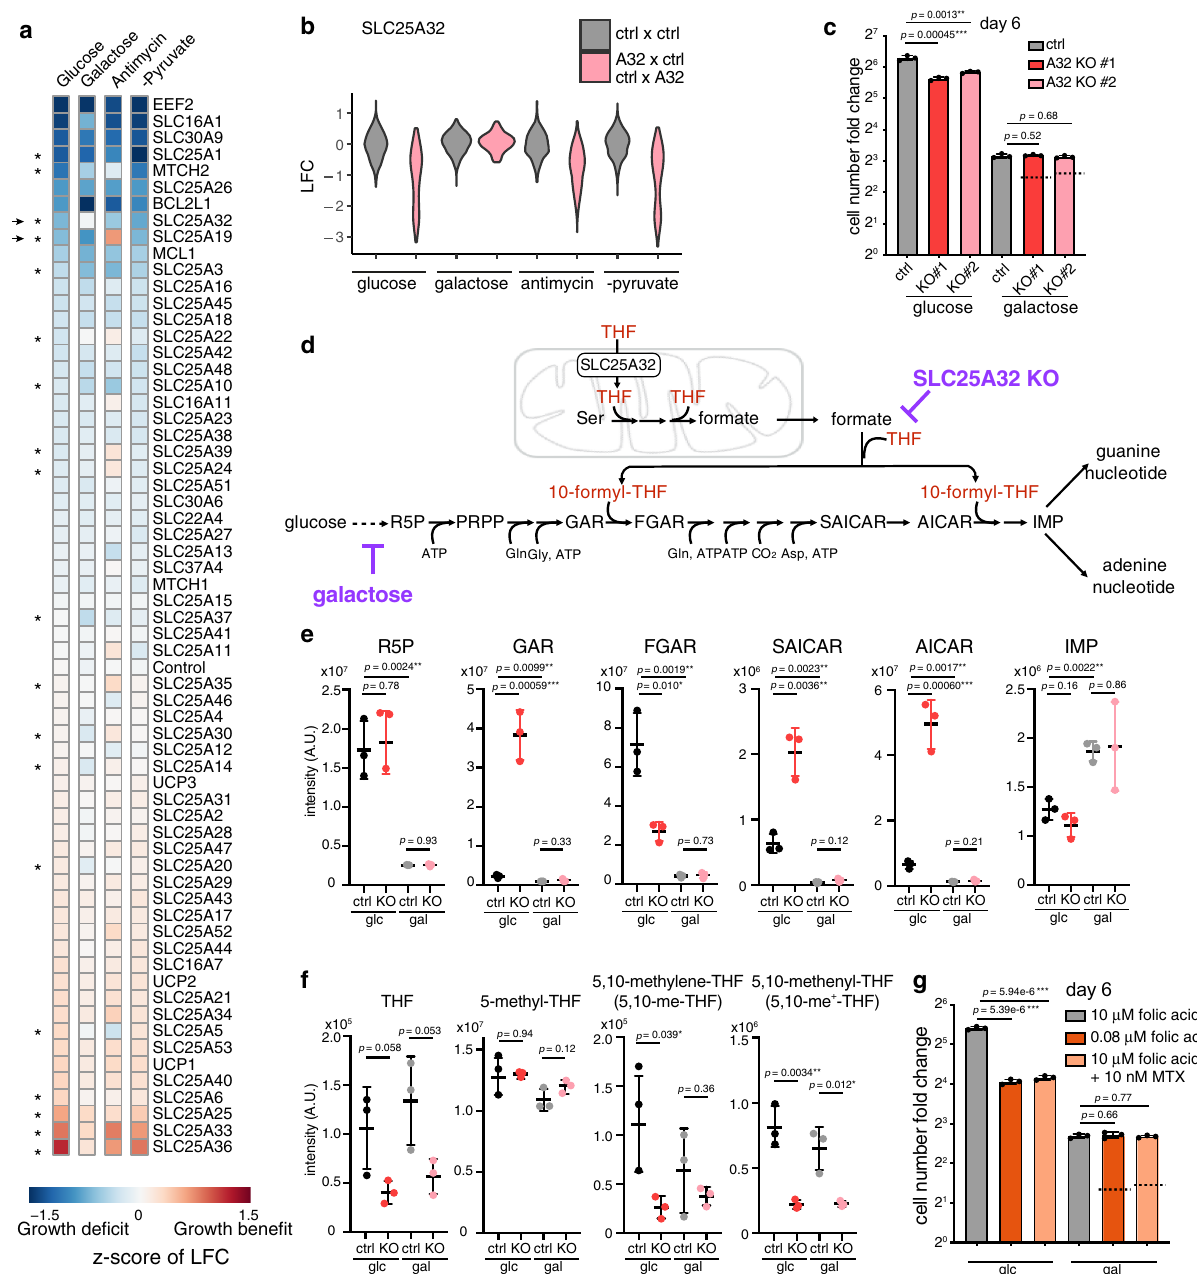
Fig. 2 Gene x Environment (GxE) mapping indicates that loss of mitochondrial folate metabolism can be buffered in galactose condition. a A heatmap depicts the fi tness of single gene KOs across all four media conditions. Values are Z -scores of log fold change (LFC) value of the targeting guide abundance. Asterisks highlight the 19 signi fi cant “ GxE ” interactions, i.e., those knockouts that cause fi tness phenotypes differentially across the conditions. Arrows indicate two hits that were experimentally validated and pursued in the current study: SLC25A32 and SLC25A19 (see Supplementary Fig 2). b SLC25A32 single KO phenotype across four conditions in the screen, showing the buffering effect in galactose. Gray, the control-control distribution; pink, SLC25A32 single KOs ( “ A32 x Ctrl ” or “ Ctrl x A32 ” combined). c Follow-up studies show growth fi tness of SLC25A32 CRISPR KO cells generated by two different sgRNAs in glucose and galactose conditions. The dotted line denotes the expected LFC, based on an additive model, if there was no genetic interaction ( n = 3). d de novo purine biosynthesis pathway. e LC-MS measurement of purine intermediates in SLC25A32 KO and control cells in glucose and galactose condition for 2 days ( n = 3). f LC-MS measurement of tetrahydrofolate (THF) cofactors in SLC25A32 KO and control cells in glucose and galactose condition for 2 days ( n = 3). g Growth fi tness of wild type cells either cultured in low folate media (0.08 μ M) or treated with DHFR inhibitor methotrexate at sub-IC50 dose (10 nM), in glucose and galactose condition. The dotted line denotes the expected LFC, based on an additive model, if there was no genetic interaction ( n = 3). Statistical signi fi cance was calculated using two-tailed t test. Signi fi cance level were indicated as *** p < 0.001, ** p < 0.01, * p < 0.05 and n.s. p > 0.05. Data are expressed as mean ± SD. Source data are provided as a Source Data fi